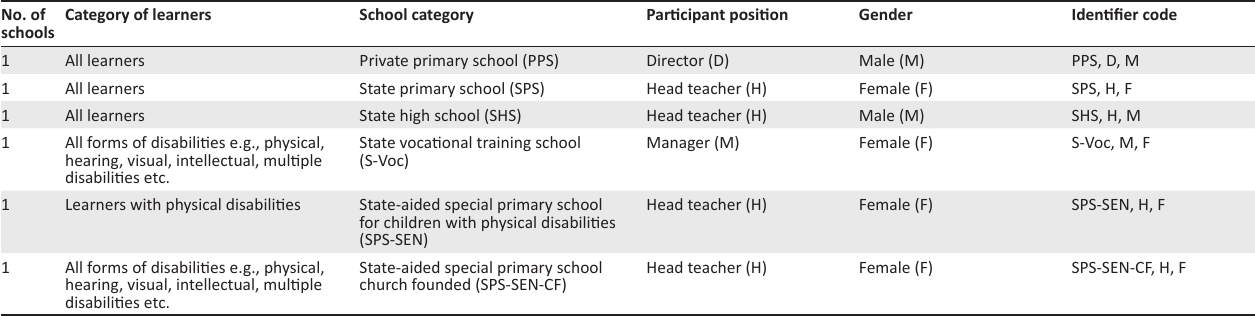
TABLE 1: A description of schools that participated in the study. No. of Category of schools